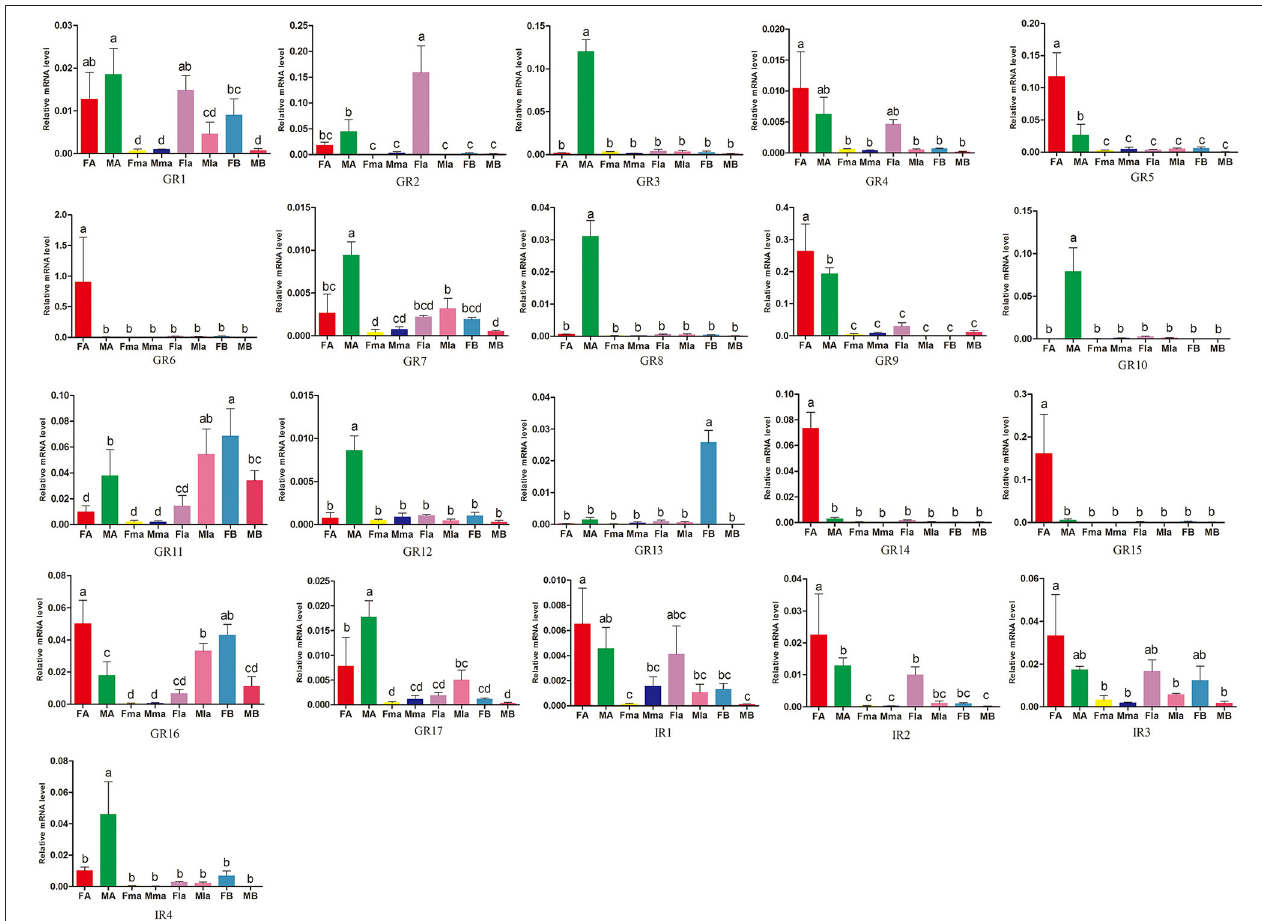
FIGURE 6 | Expression levels of A. chinensis GRs and IRs in different tissues of female and male adults as measured by RT-qPCR. FA: female antennae, MA: male antennae, Fma: female maxillary palps, Mma: male maxillary palps, Fla: female labial palps, FB: female bodies (with antennae, maxillary palps and labial palps cut off), MB: male bodies (with antennae, maxillary palps and labial palps cut off). The bar represents standard error and the different small letters (a–d) above each bar indicate significant differences ( P <